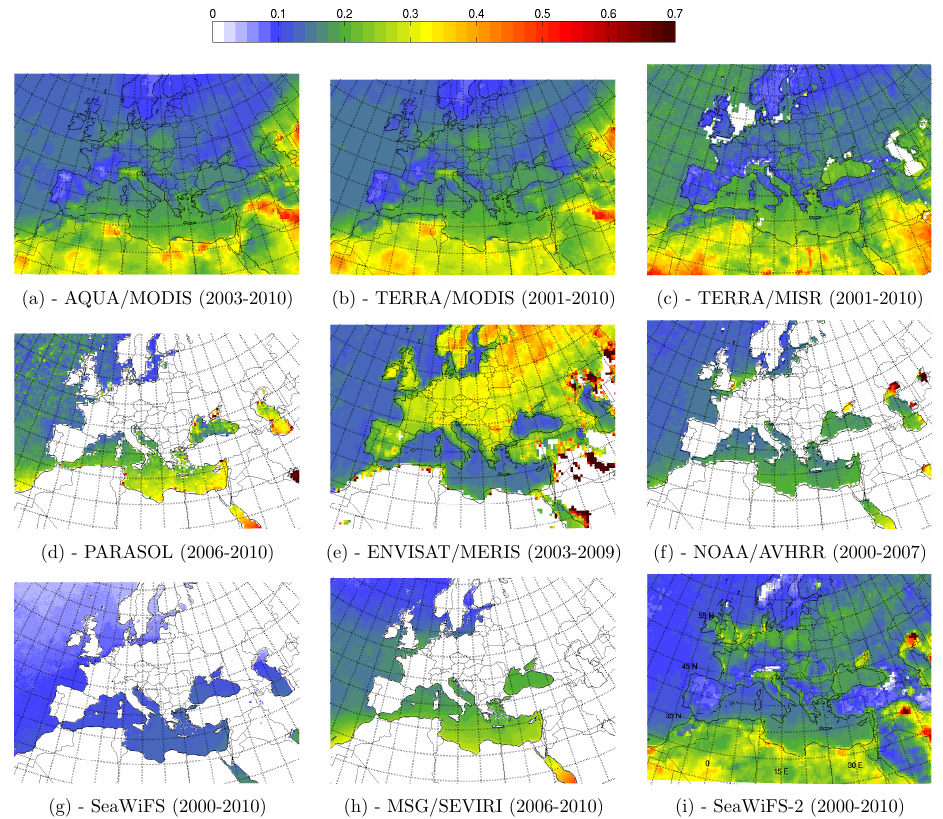
Fig. 2. Mean Aerosol Optical Depth (AOD) at 550nm from different satellite sensors over the Mediterranean